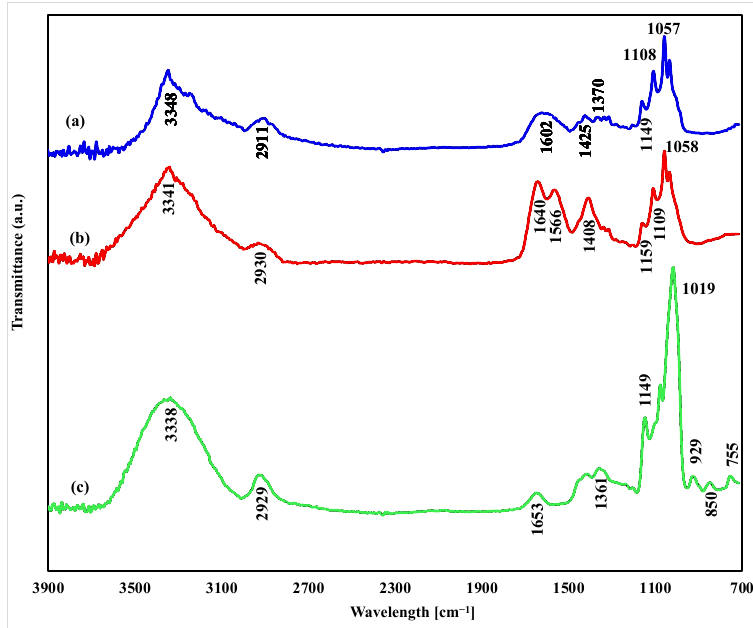
Figure 4. FTIR spectra of ( a ) BC/PUL, ( b ) BC, and ( c ) PUL.